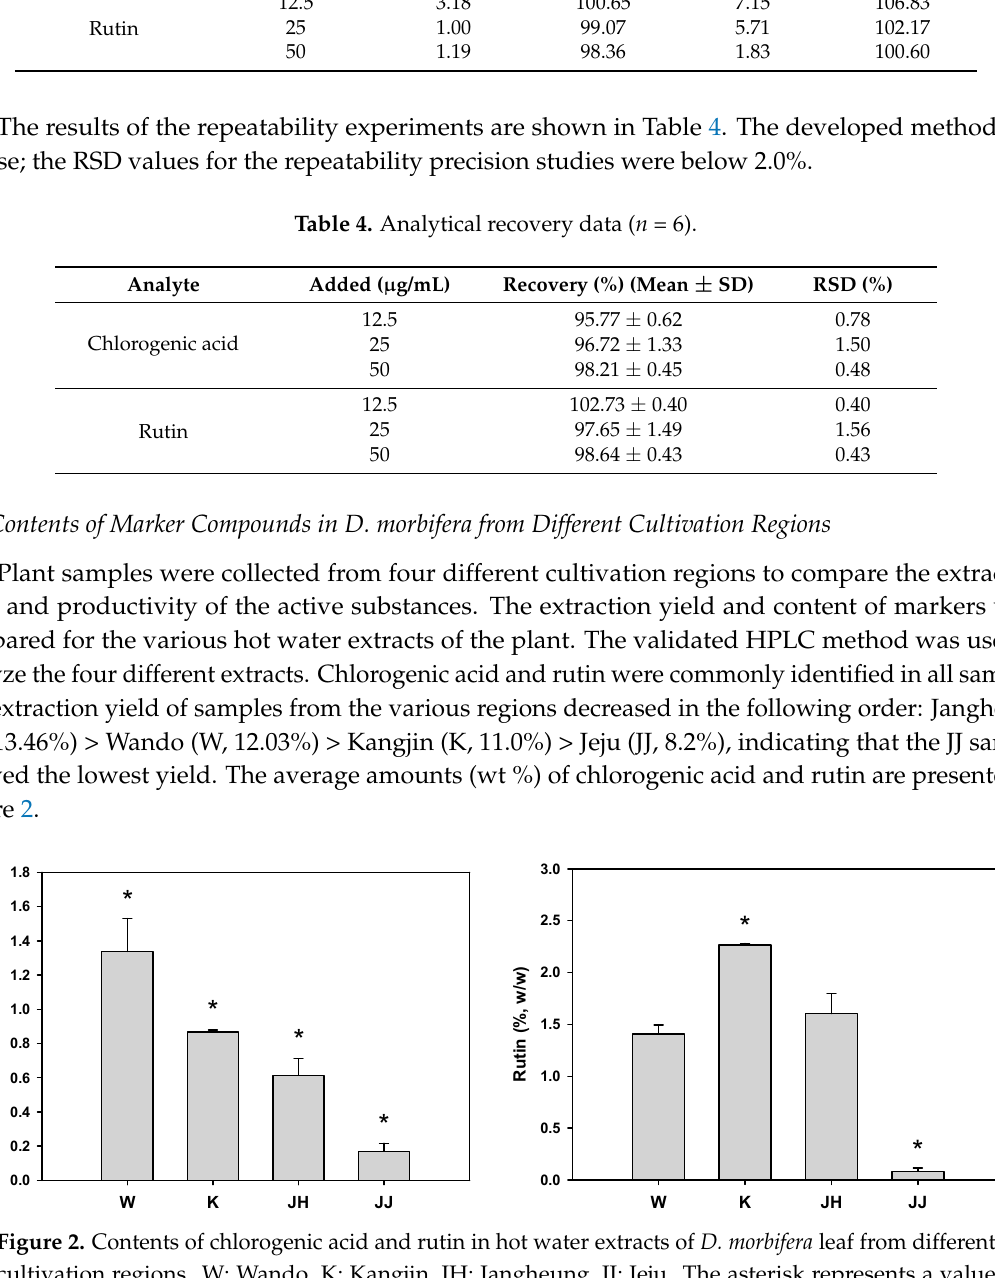
Figure 2. Contents of chlorogenic acid and rutin in hot water extracts of D. morbifera leaf from different cultivation regions. W: Wando, K: Kangjin, JH: Jangheung, JJ: Jeju. The asterisk represents a